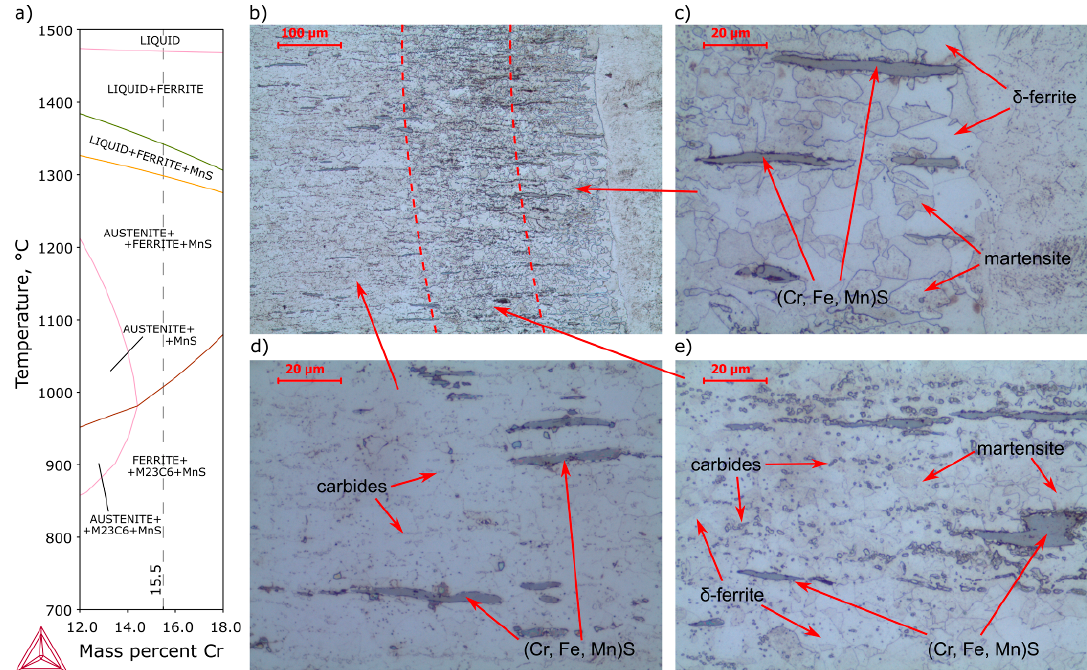
Figure 3. Microstructure of AISI 430F (X12CrMoS17) steel heat-affected zone: ( a ) pseudobinary phase diagram of 0.17C-0.48Si-0.8Mn-0.028P-0.497S-0.26Mo-0.33Ni-0.12Cu-0.05V steel, ( b ) general view, ( c ) coarse-grain heat-affected zone, ( d ) base metal, ( e ) intercritical heat-affected zone (Kalling’s and CrO 3 etched).